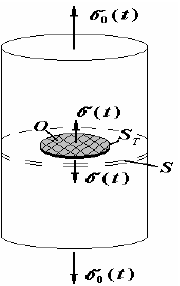
Fig 1. Crack growth in the material model with structural het- erogeneity: S — cross-section area of the specimen; S T — area of heterogeneity; О — elementary volume in the area of hetero-